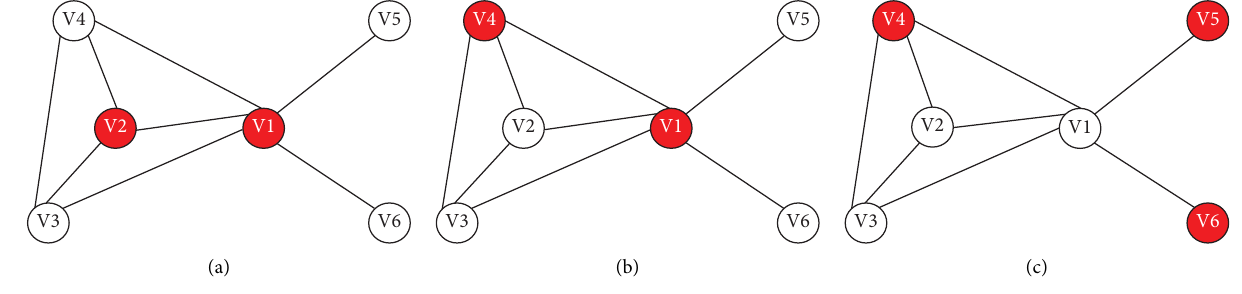
Figure 1: An example of a minimum dominating